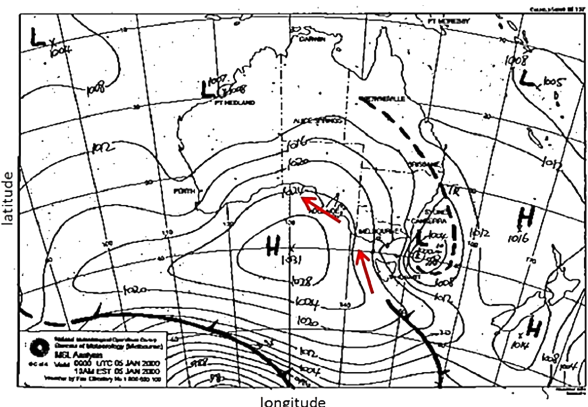
Figure 2. Mean sea level pressure for 6 January 2000, courtesy of the Bureau of Meteorology (Australia) (http://www.bom.gov. au/cgi-bin/charts/). Arrows indicate upwelling-favourable coastal winds, influenced by a blocking low-pressure cell over